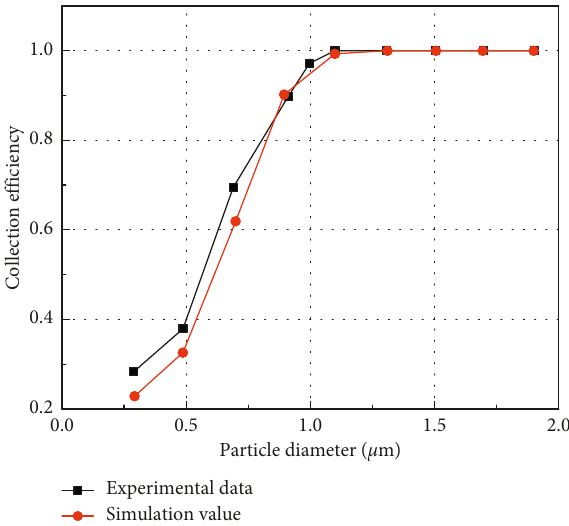
Figure 3: Collection efficiency curve of the designed particle